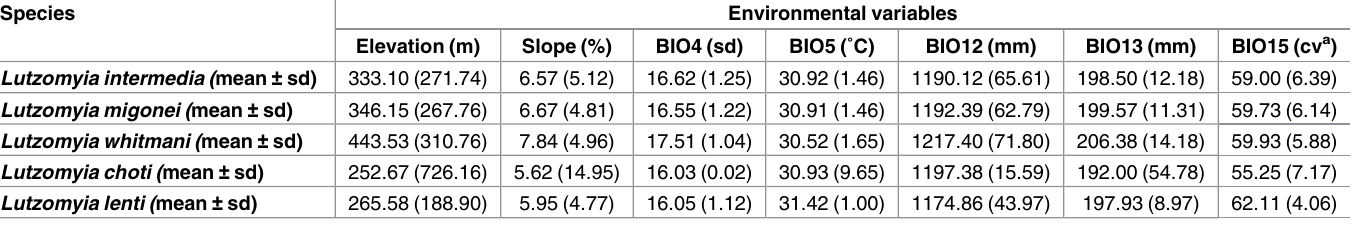
Table 2. Environmental variable values of the sample sites of five phlebotomine species in the state of Espı´rito Santo, Brazil, 1997–2013. The mean value and standard deviation(sd) for each variable are reported.